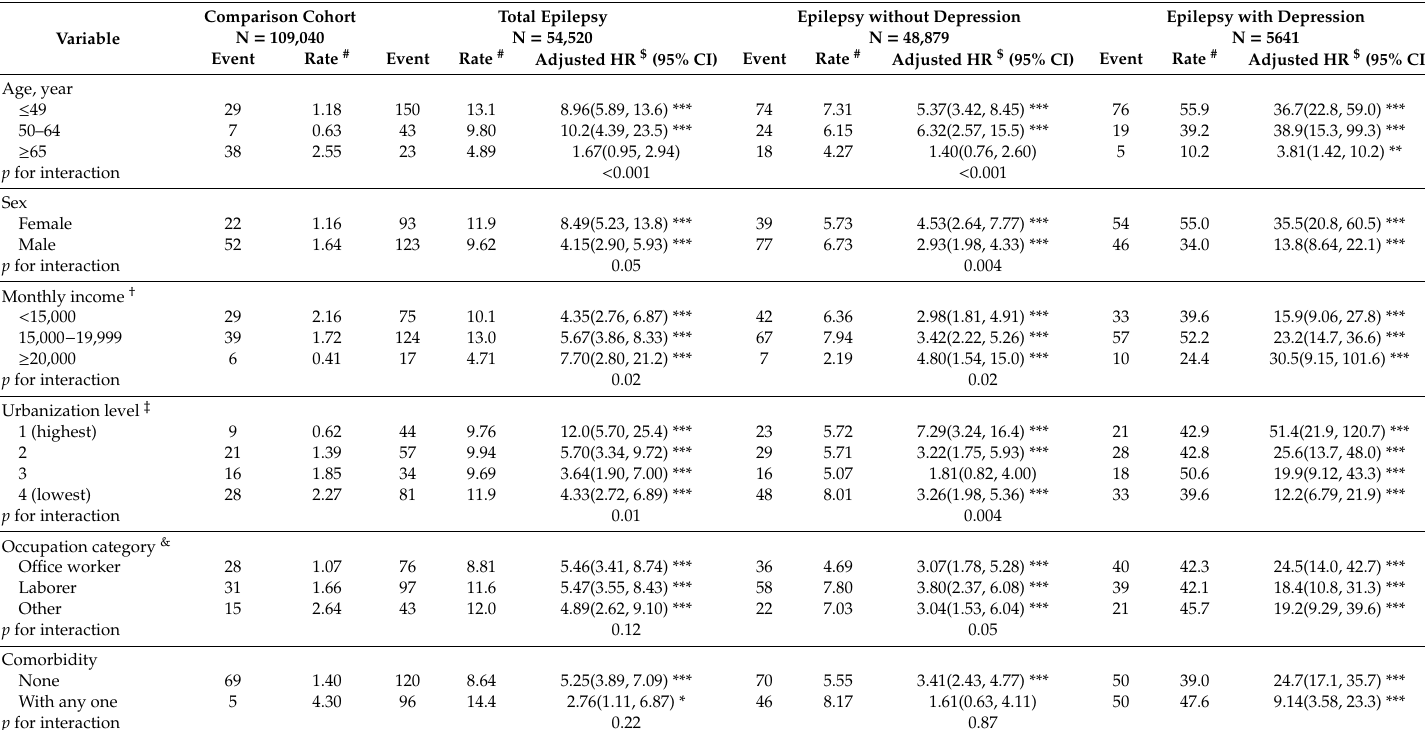
Table 3. Incidence and hazard ratios for SA stratified by age, sex, income, urbanization, occupation, and comorbidity.